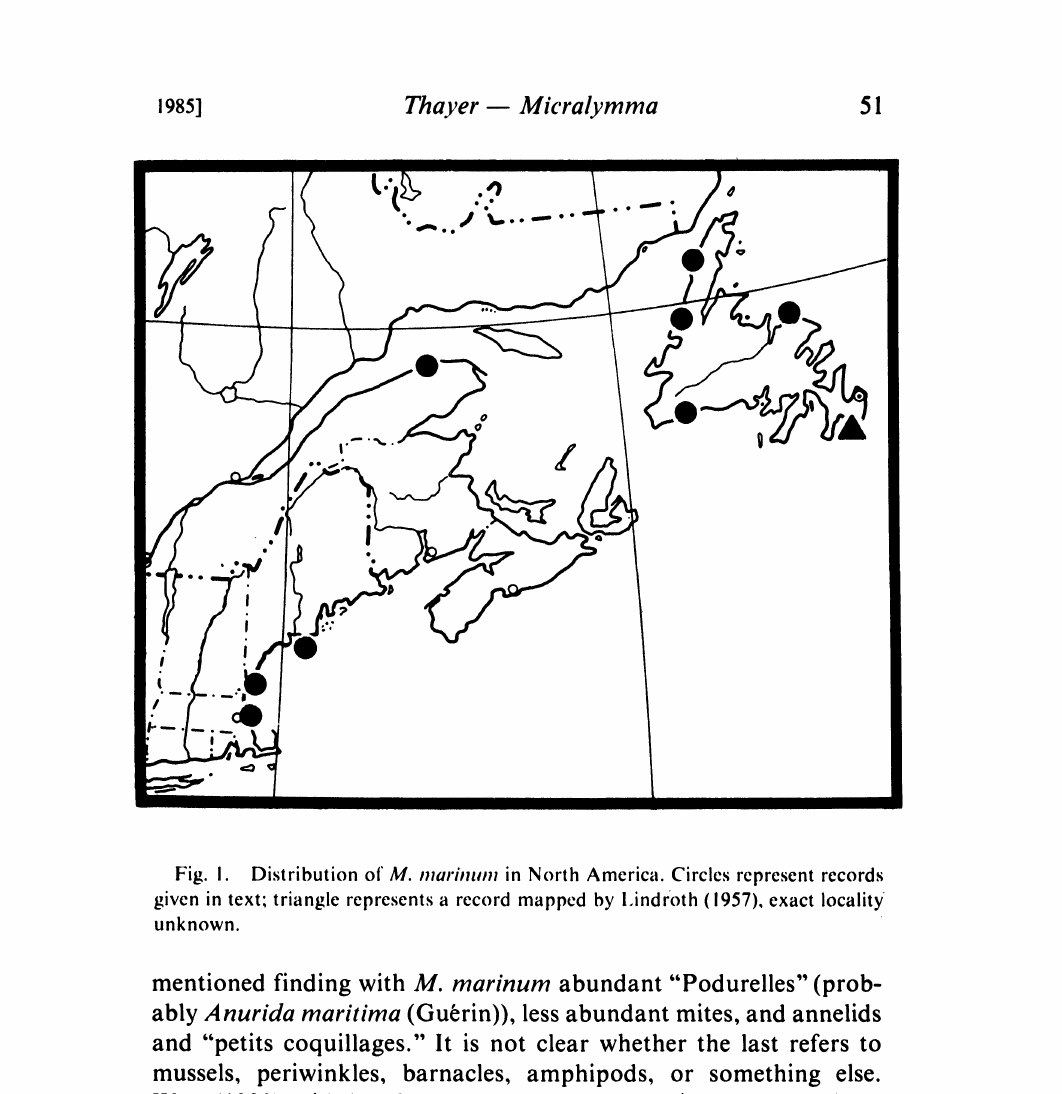
Fig. I. Distribution of M. marinum in North America. Circles represent records given in text: triangle represents a record mapped by l,indroth (1957L exact locality